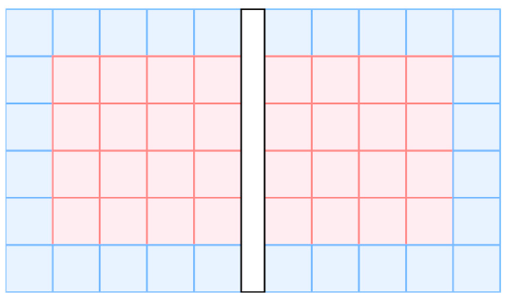
Figure 13. Schematic of the color space weight distribution.